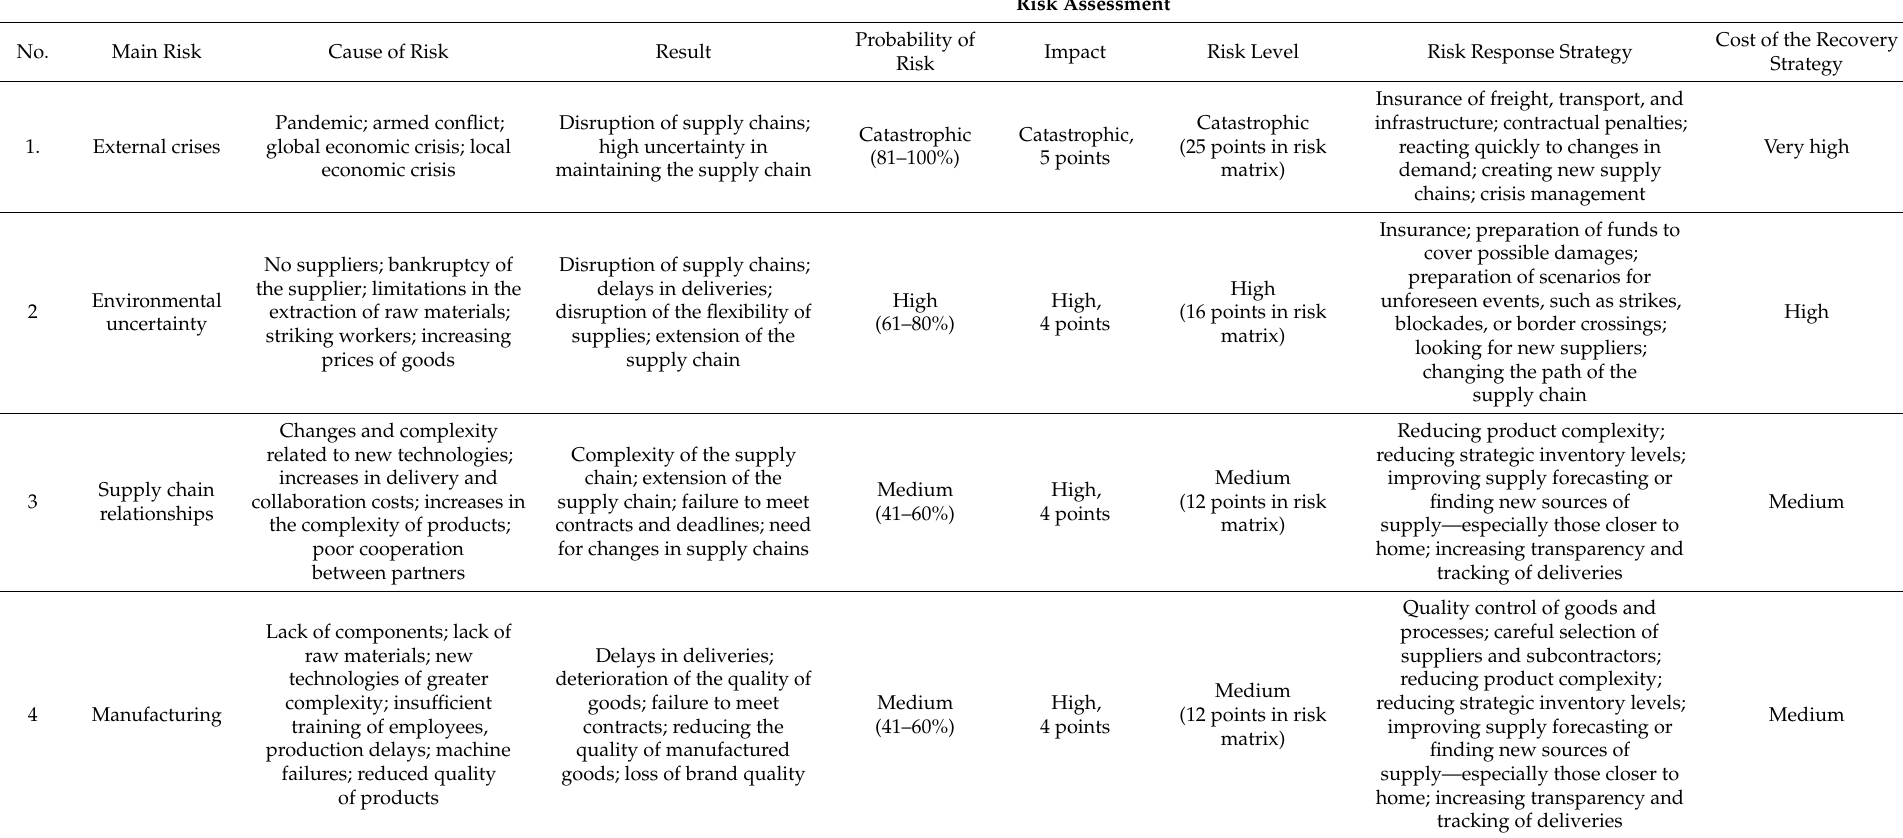
Table 5. Assessment of the possibility of key risks in supply